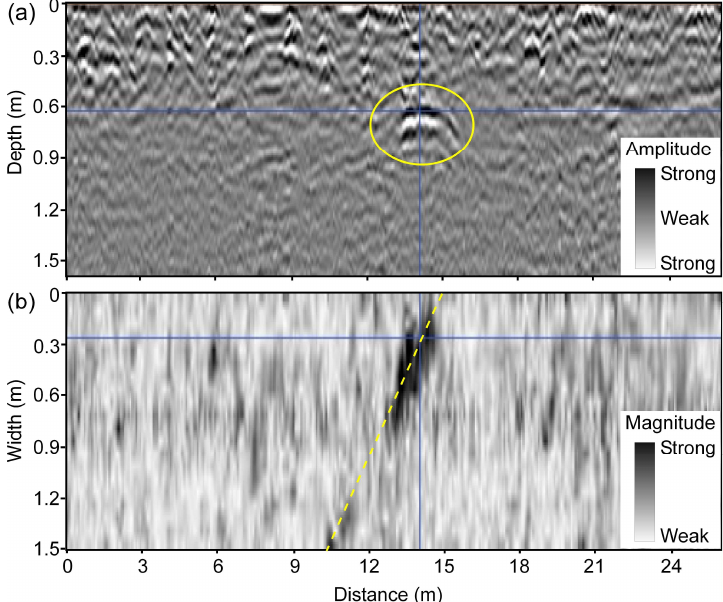
Figure 6. An example from Fensholt upland showing the typical signature of a drain line marked in yellow when the 3D-GPR traverse is at an angle to drain line orientation: ( a ) hard to recognize hyperbolic pattern in the vertical profile of reflections (amplitude) and ( b ) linear pattern in the horizontal slice (~0.6 m depth) of reflection strength